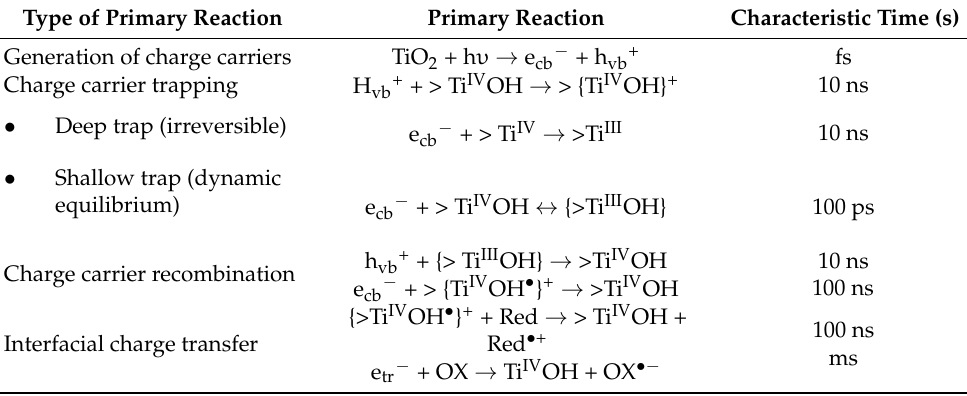
Table 1. Characteristic times for heterogeneous photocatalysis on TiO 2 : where e cb − is the conduction band electron, h vb+ is the valence band hole, e tr − is the trapped conduction band electron, >TiOH shows the primary hydrated surface functionality of titania, >Ti IV OH • + is the surface-bound hydroxyl radical, >Ti III OH is the surface-trapped conduction band electron, Red is the reductant, and OX is the oxidant